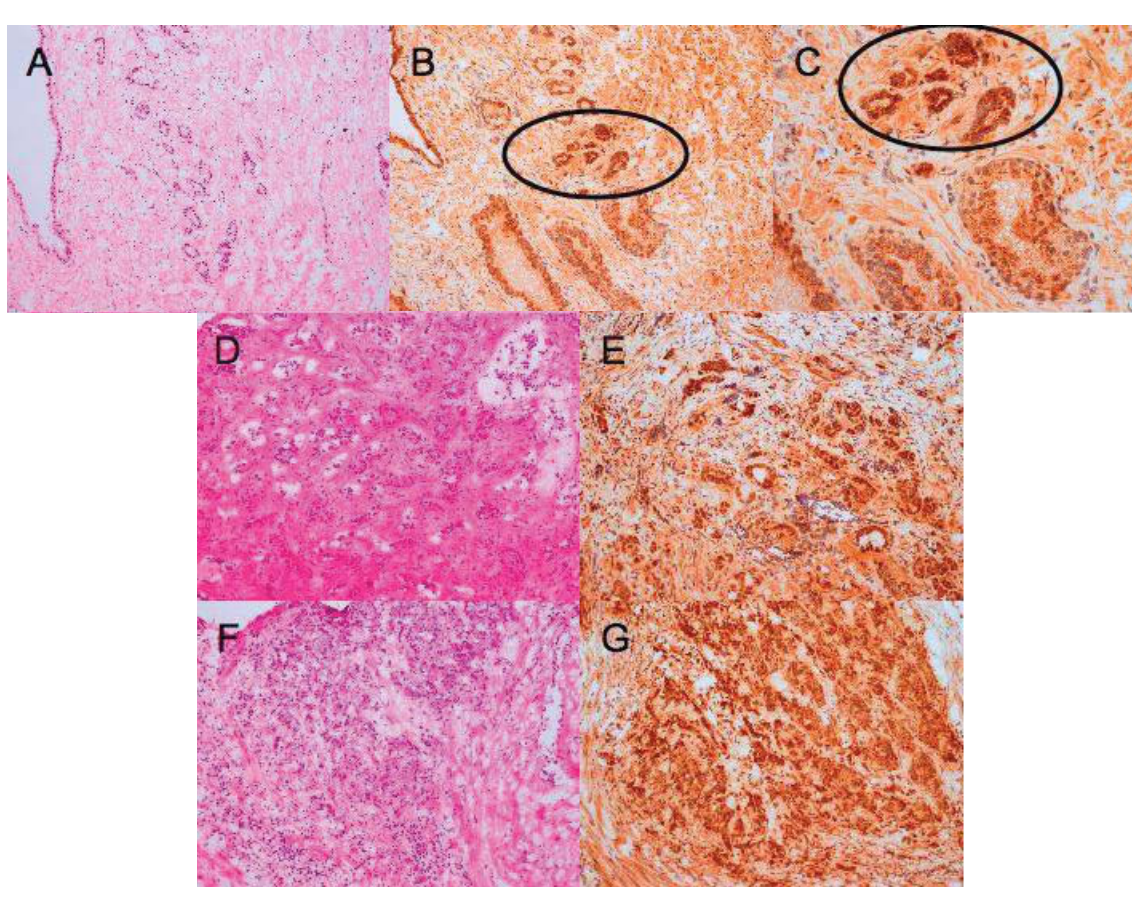
Figure 5. Interleukin-4 immunoreactivity in prostate cancer sections. ( A ) H & E, ( B ) anti-IL-4 and ( C ) anti-IL-4 at higher magnification of a Gleason 3 + 3 prostate cancer showing increased intensity and disorder of anti-IL-4 staining in the malignant glands (circled) when compared with the surrounding normal prostate tissue; ( D ) H & E and ( E ) anti-IL-4 in a Gleason 3 + 4 cancer; ( F ) H & E and ( G ) anti-IL-4 staining in a Gleason 4 + 4 cancer. These images are representative of nine malignant tumors